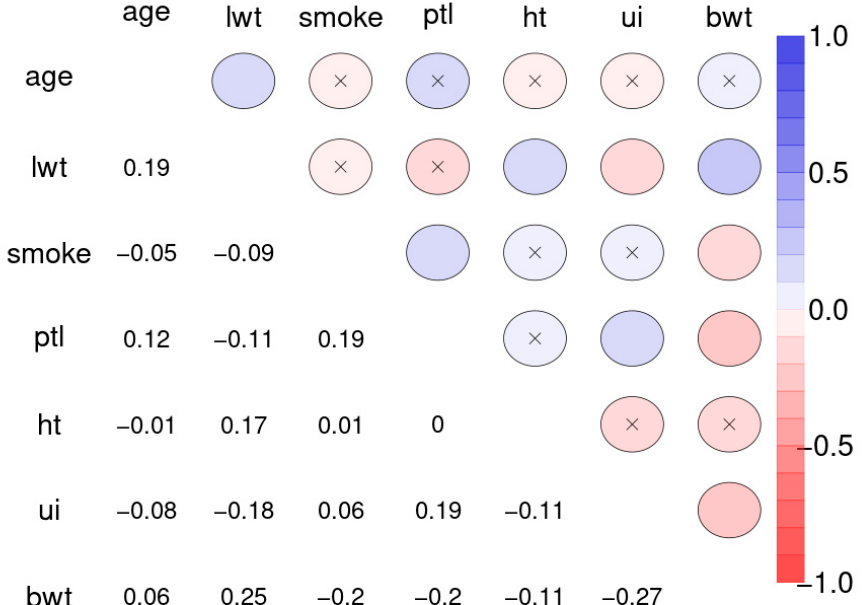
Figure 11. Spearman correlation matrix for pairwise correlations between the maternal risk factors and birth weight of 189 children. Abbreviations used: age: mothers age, lwt: last weight of the mothers at last menstrual period, smoke: status at pregnancy, ptl: premature labor, ht: history of hypertension, ui: uterine irritability, bwt: child birth weight in grams; binary status variables were encoded as 0 for no and 1 for yes.